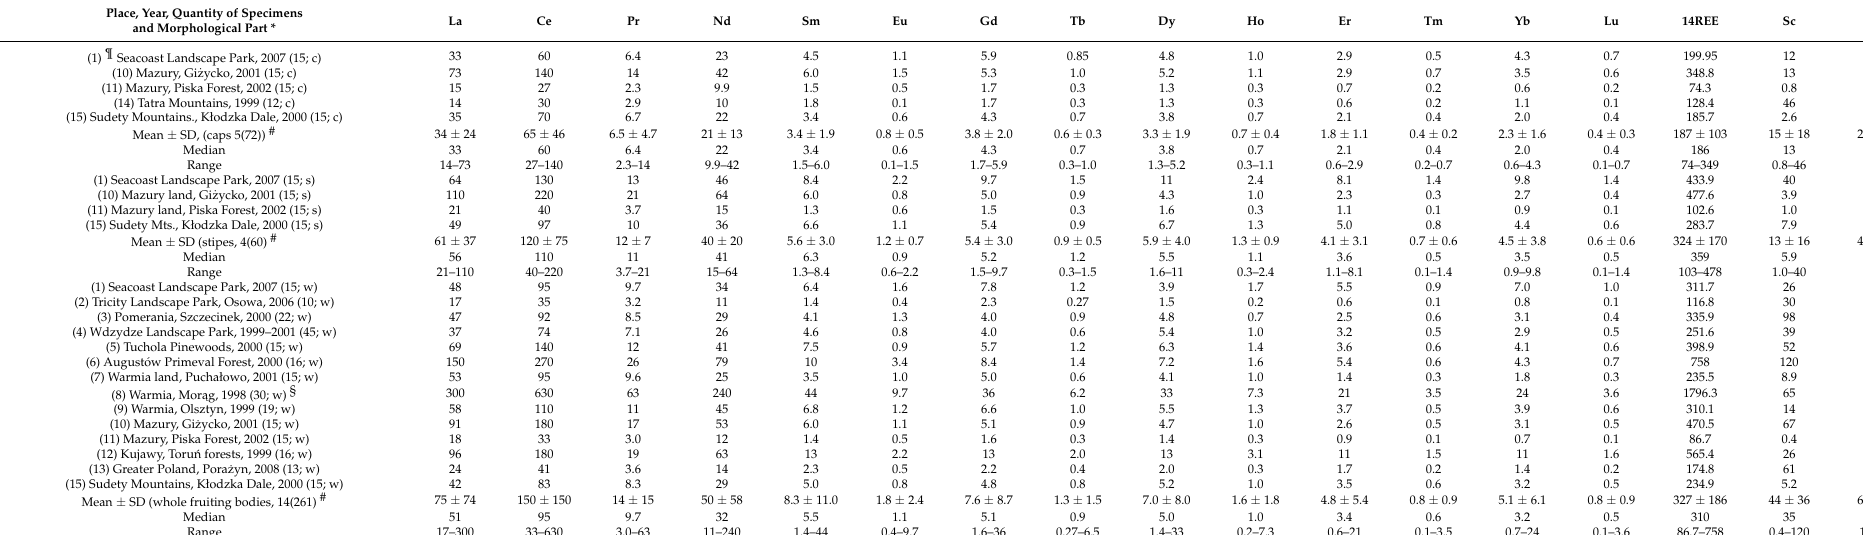
Table 1. Concentration levels of the REE, Sc and Y in the morphological parts of B. edulis ( µ g kg − 1